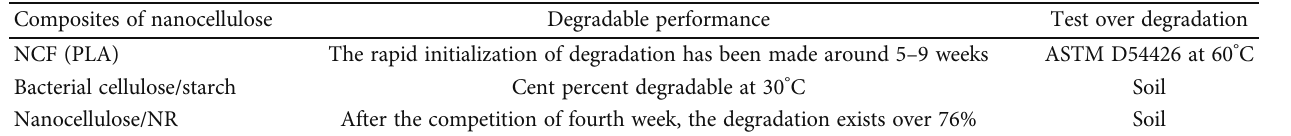
Figure 6: Illustration over the arrays of wearable integrated electronic sensors used in biohealth monitoring. Table 2: Properties of biodegradation associated with nanocellulose system of